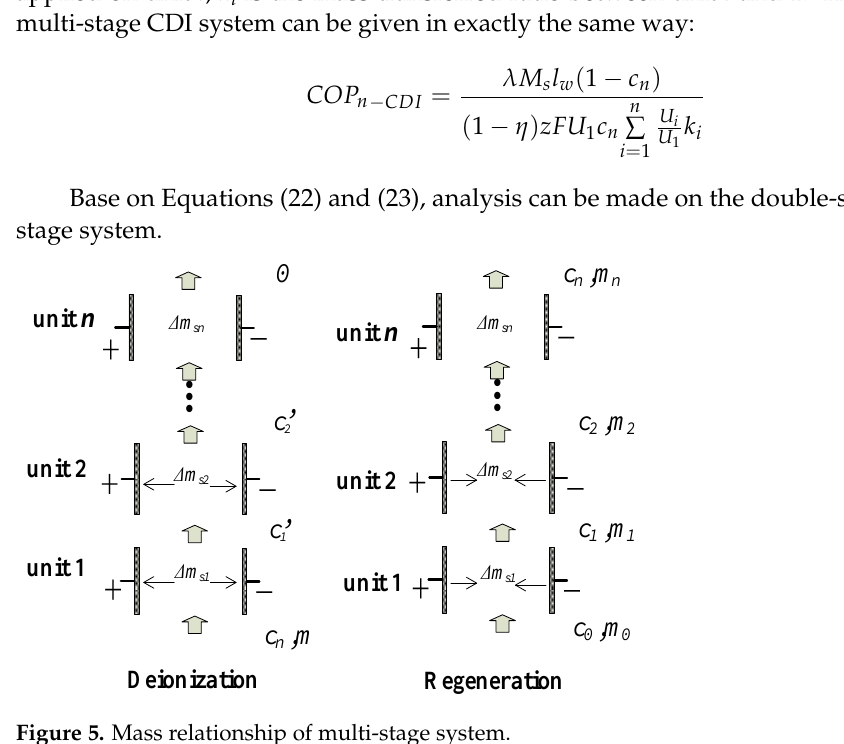
Figure 5. Mass relationship of multi-stage system.